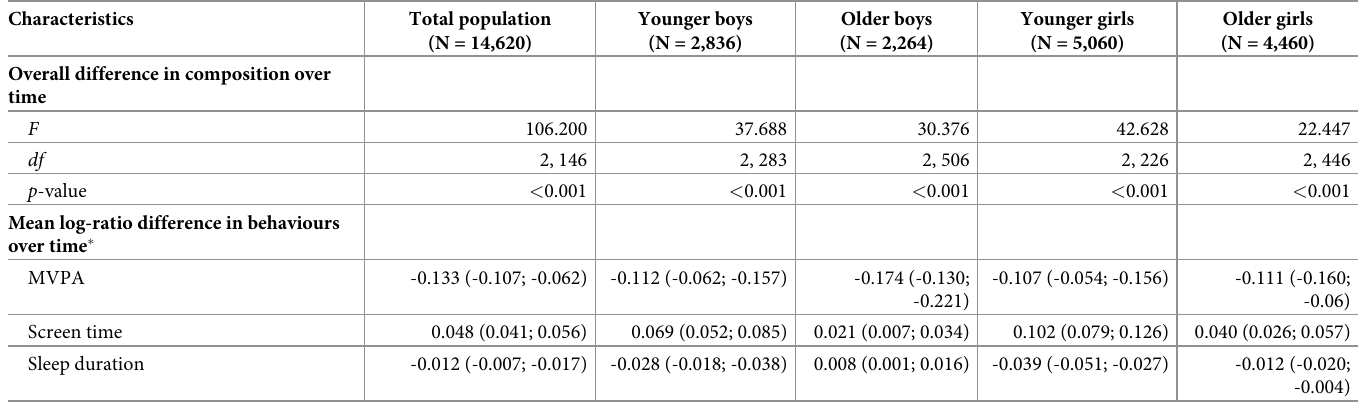
Table 2. Differences in movement behaviour composition over